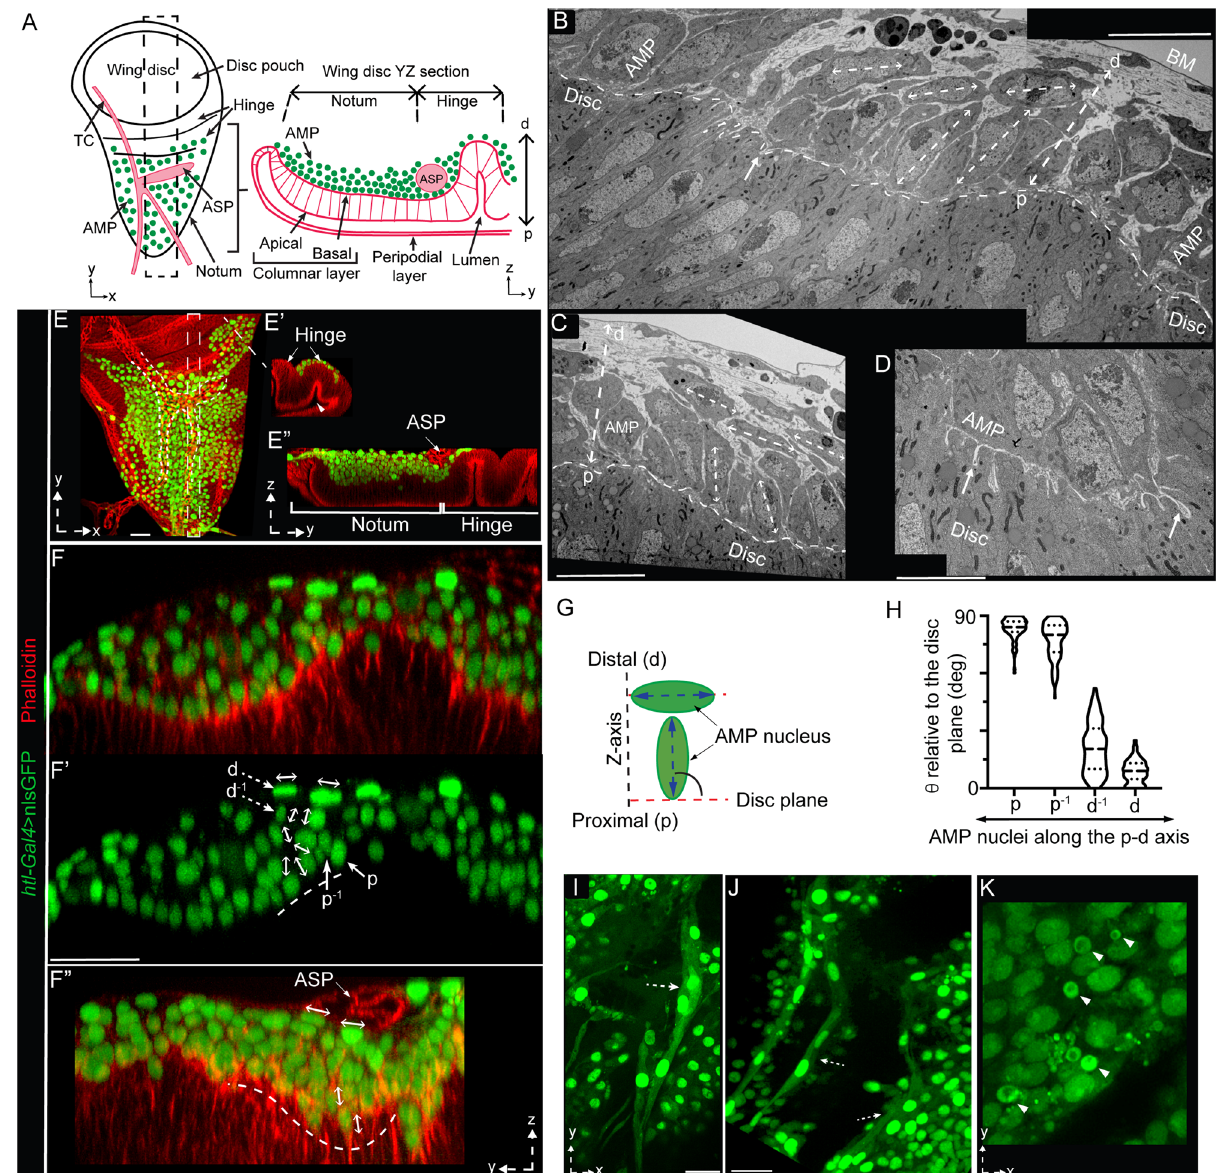
Fig. 1 Correlation of the AMP position and polarity relative to the disc. A Drawing of an L3 wing disc showing the spatial organization of AMPs, wing disc notum and hinge areas, and ASP (air-sac primordium) and TC (transverse connective); dashed box (left), ROI used for all subsequent YZ cross-sectional images. B – D TEM sections of wing disc ( w 1118 ) showing YZ views of different wing disc notum areas; double-sided dashed arrows, long axes of elliptical AMPs; p-d dashed arrow, proximo (p)-distal (d) axis relative to the disc plane (dashed line); white arrow, cytoneme-like disc-invading projections from AMPs ( D see Supplementary Fig. 1A,A ’ ); BM basement membrane. E – E ” Spatial organization of nls:GFP-marked AMP nuclei, orthogonal to the wing disc notum ( E , E ” ) and hinge ( E , E ’ ) as illustrated in A . F – H Cross-sections of wing disc regions (indicated in ROI box in A ) harboring nls:GFP-marked AMPs; double-sided arrows, nuclear orientation; F ’ green channel of F ; dashed and solid arrows, distal and proximal layer cells, respectively; G drawing illustrating the strategy to measure nuclear orientation as angles (Theta, θ ) between AMP nuclei and the disc plane; H graph showing quantitative analyses of AMP nuclear orientation at different disc-relative locations; p: proximal (125 nuclei), d: distal (58 nuclei), p − 1 : one layer above p (119 nuclei), d − 1 : one layer below d (84 nuclei); also see Supplementary Table 1 and see “ Methods ” section for statistics; source data are provided as a “ Source Data ” fi le. I – K Single XY optical sections of the discs, showing diverse morphologies of distal AMPs; dashed arrows, elongated syncytial cells; arrowhead, small nonpolar cells (also see Supplementary Fig. 1B – D ’ ). E , F ” red, phalloidin, marking tissue outlines (also indicated by dashed line). Genotype: UAS-nls:GFP/ + ; htl-Gal4/ + ( E – K